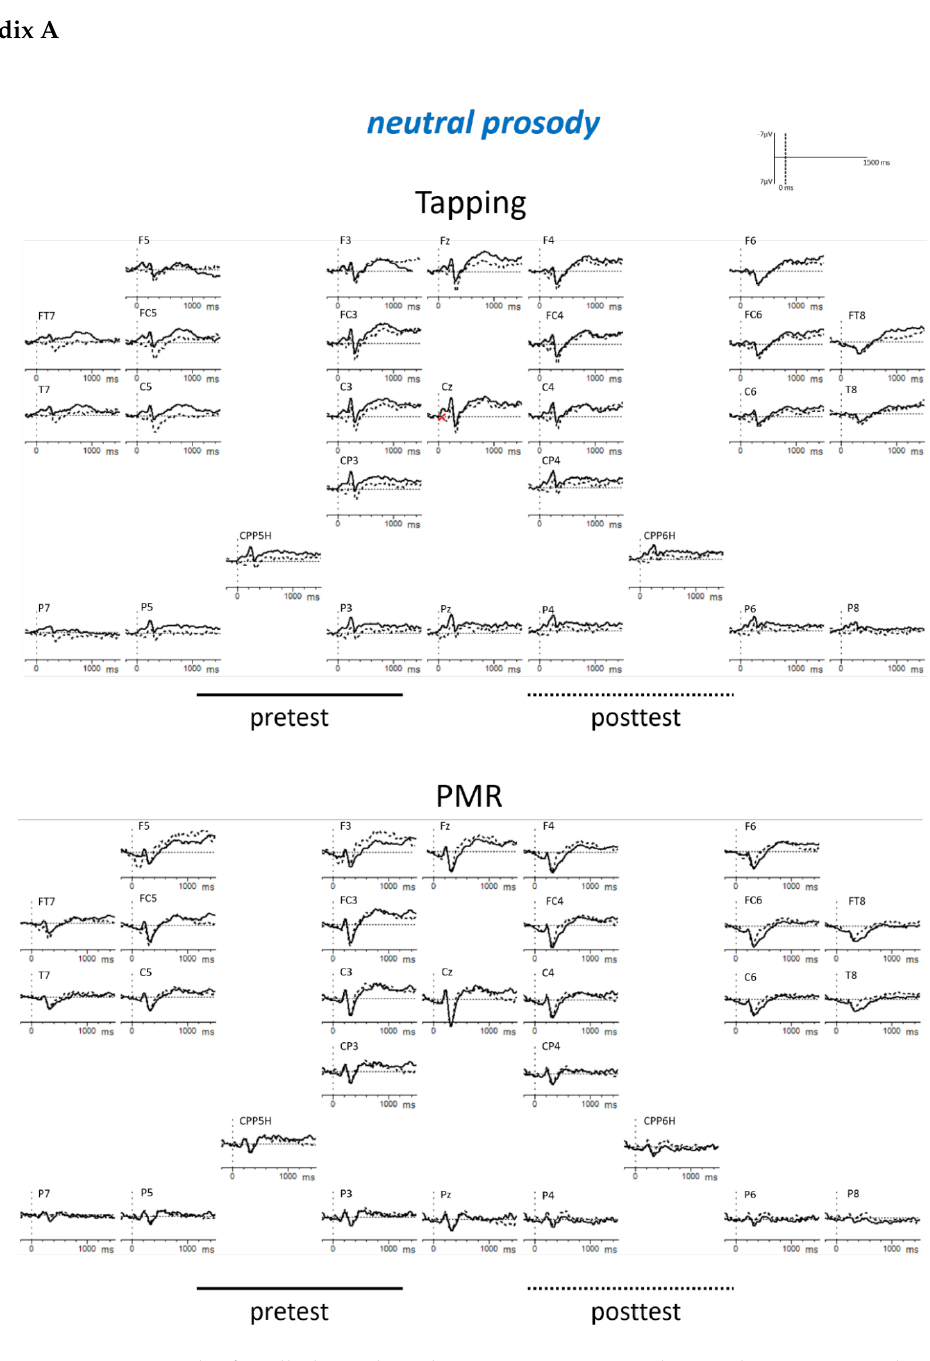
Figure A1. EEG results for all electrodes when processing neutral prosody. Positive polarity is plotted downwards.